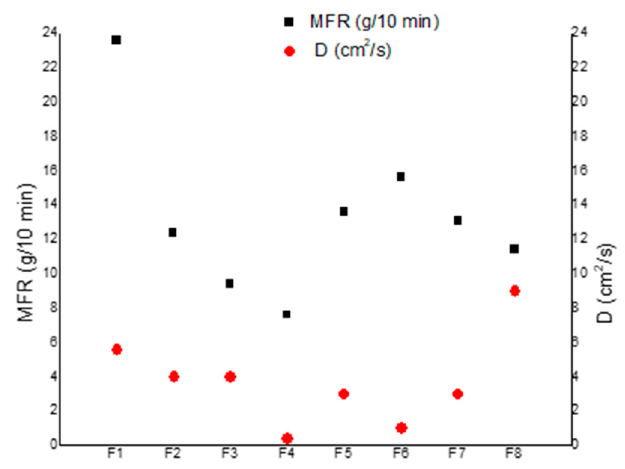
Figure 7. Comparison between MFR data and D calculated by Equation (6).